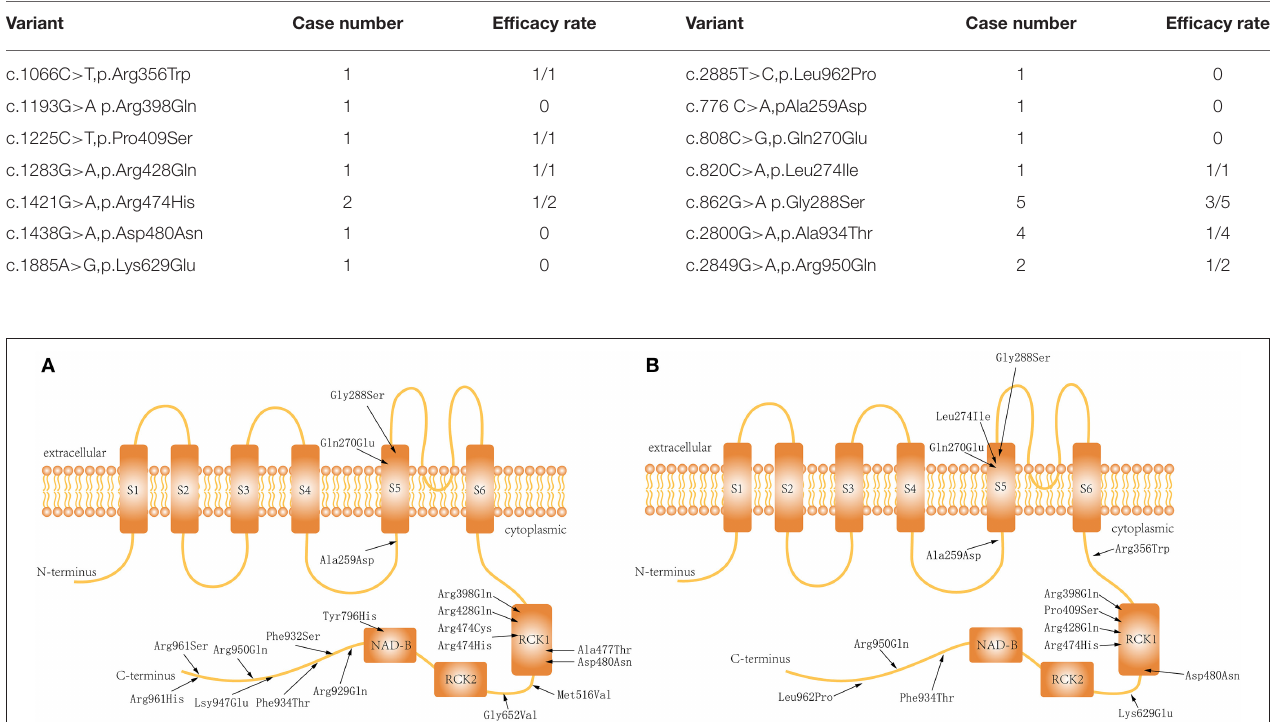
TABLE 2 | Patients with KDT (including our patients) (5, 12).